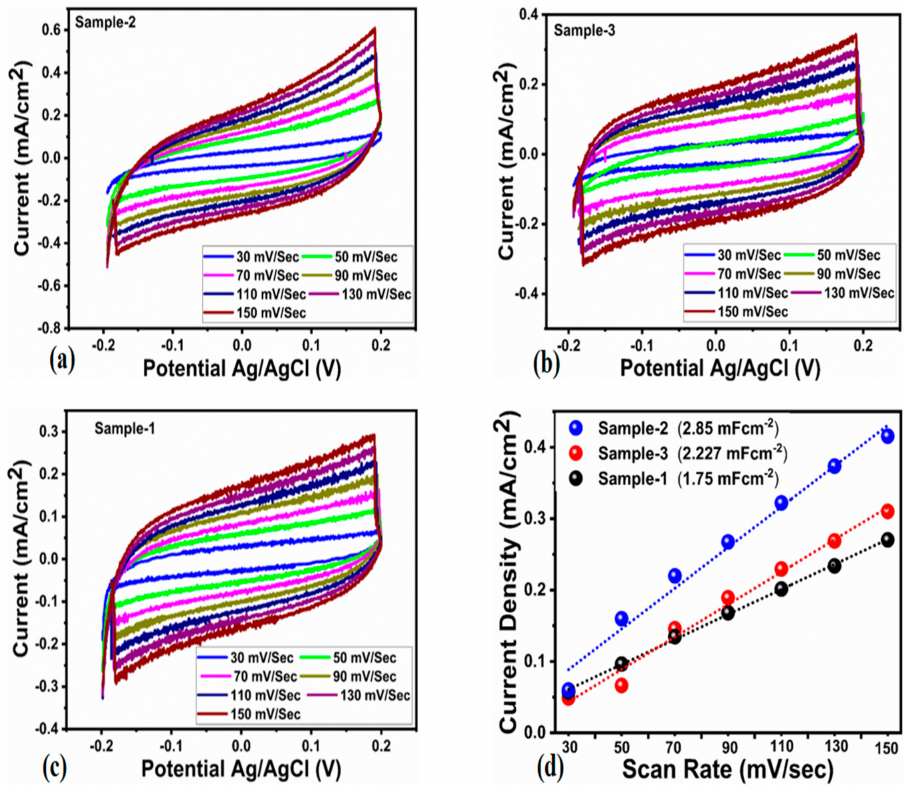
Figure 7. ( a – c ) Cyclic voltammetry measured for Samples 2 and 3 and Sample 1 in 0.5 mM urea solution at different scan rates. ( d ) Linear plots of anodic and cathodic current density difference for each scan rate for the quantification of (ECSA).